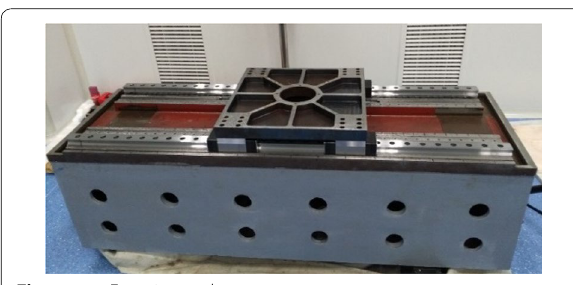
Figure 15 Experimental set-up